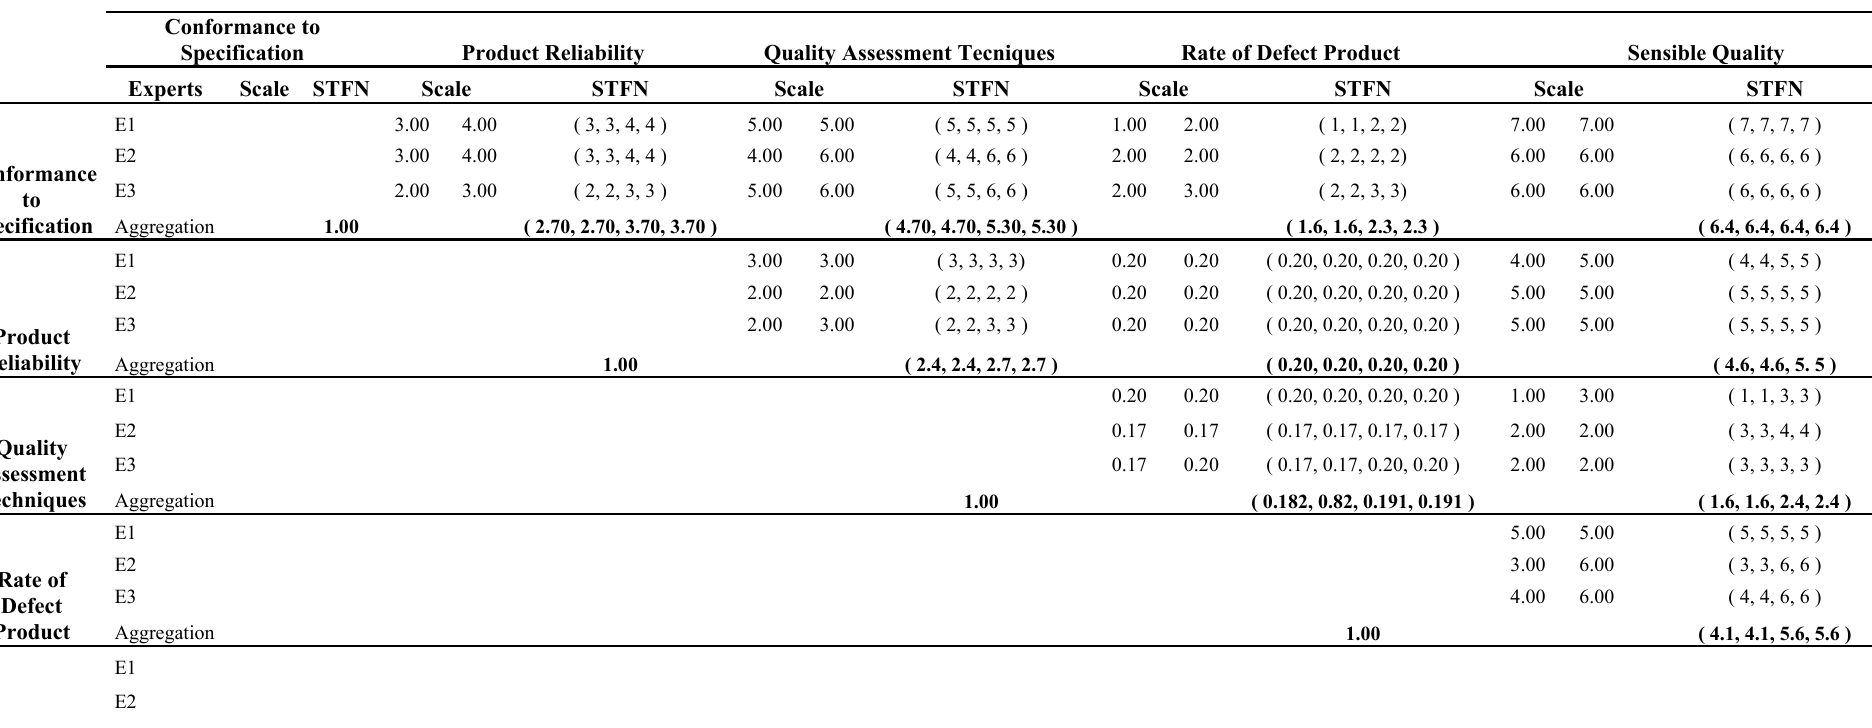
Table 3 Fuzzy weights of sub-attributes of